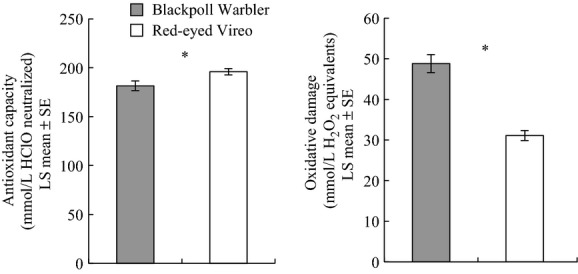
Antioxidant capacity (ANCOVA, with fat score as covariate) was lower in Blackpoll Warblers than Red-eyed Vireos, and oxidative damage was higher in Blackpoll Warblers than Red-eyed Vireos in autumn on Block Island, USA. Asterisks indicate a significant difference between species (P < 0.05).